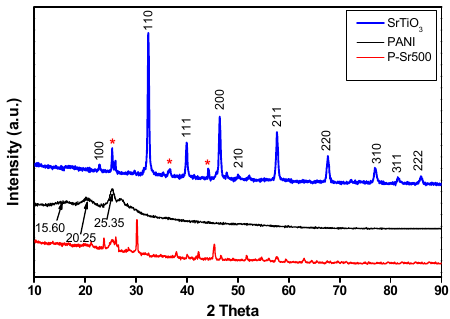
Figure 5. XRD patterns of PANI, SrTiO 3 and P-Sr500 nanocomposite.